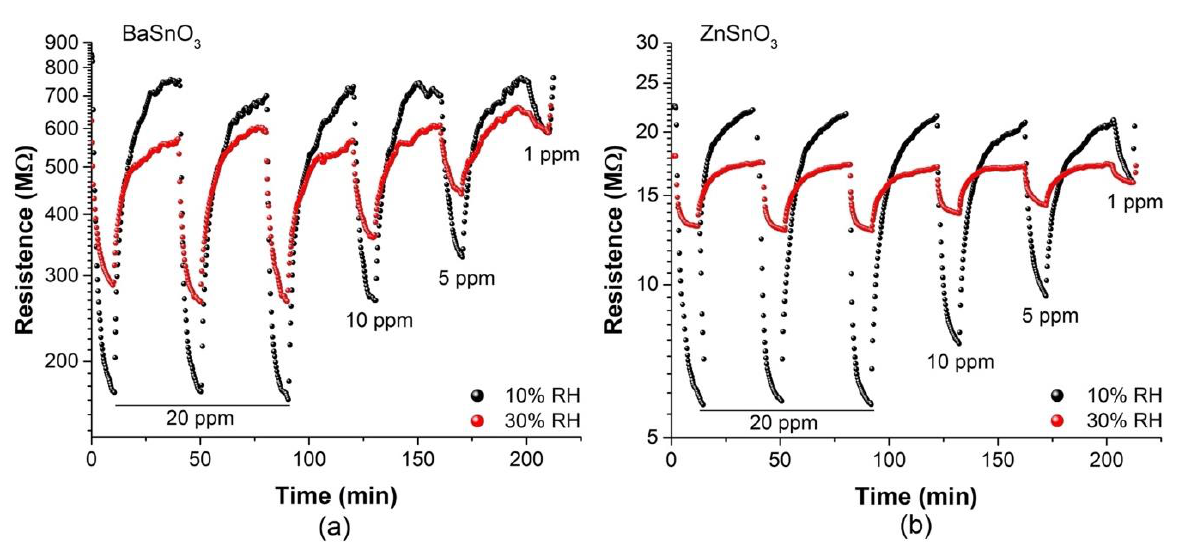
Figure 13. Dynamic response – recovery cycles in different relative humidity conditions. ( a ) BaSnO 3 and ( b ) ZnSnO 3 sensors, exposed for 10 min to various concentrations of ethanol and acetone, respectively, at operating temperature of 270 °C.